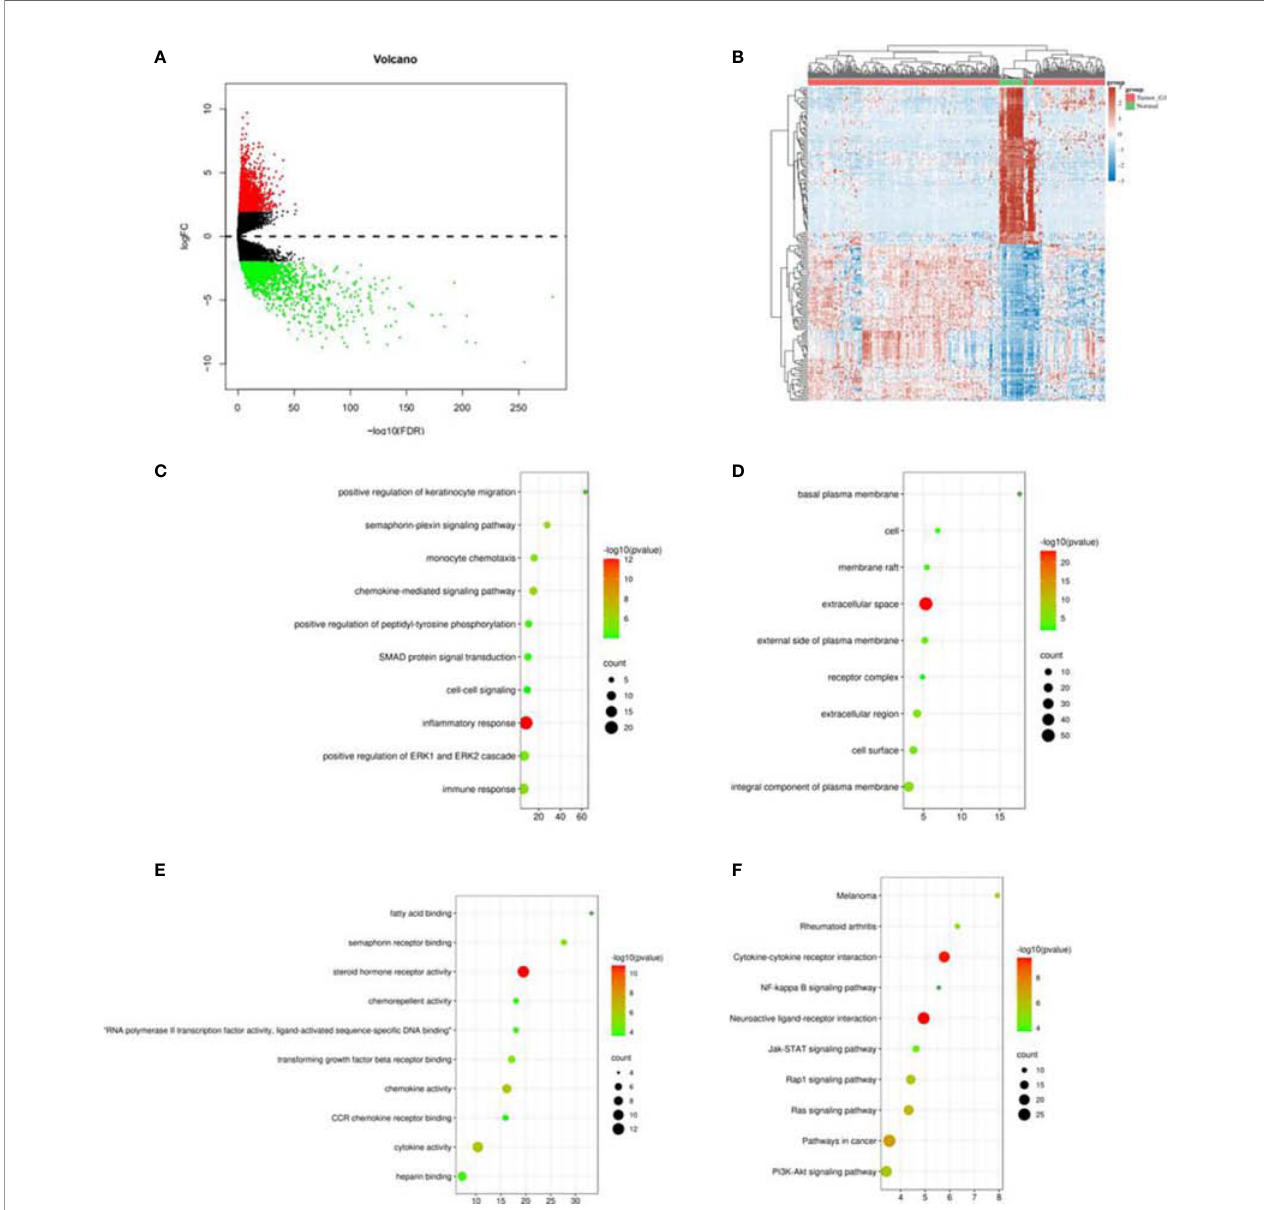
FIGURE 1 | Differential expression genes in TCGA KIRC data and enrichment analysis. (A) Volcano plot in the differential expression genes (DEGs) in TCGA KIRC data; (B) the heatmap of top 50 DEGs; (C) the biological process in GO term; (D) the cellular component in GO term; (E) the molecular function in GO term; (F) the pathway analysis in KEGG